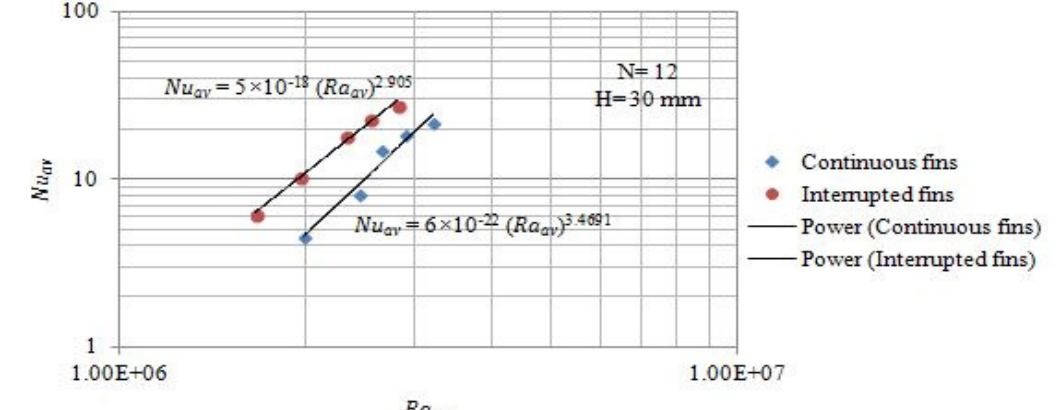
Fig. 9. Experimental analysis of present data for continuous and interrupted longitudinal fins with concluded correlations.